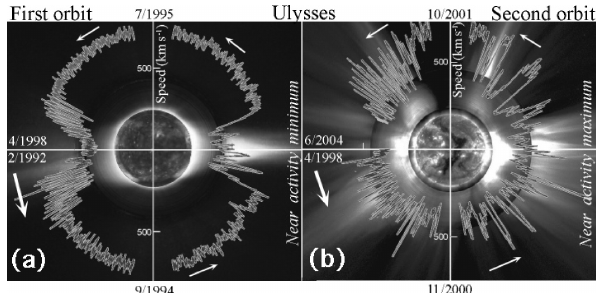
Figure 13. (a) An erupting prominence in He II 304 with the size of the Earth indicated (from the AIA instrument on SDO). (b) A coronal mass ejection observed by the LASCO instrument on-board SOHO.